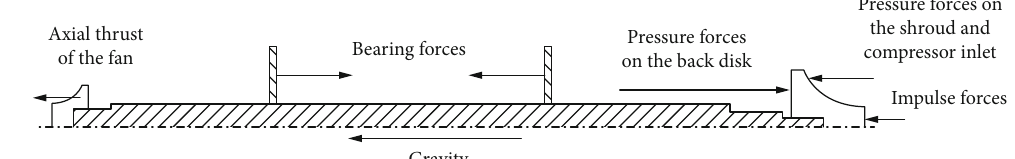
Figure 1: Schematic view of the studied centrifugal compressor, the locations of the axial magnetic bearings, and the force components of the net axial thrust.